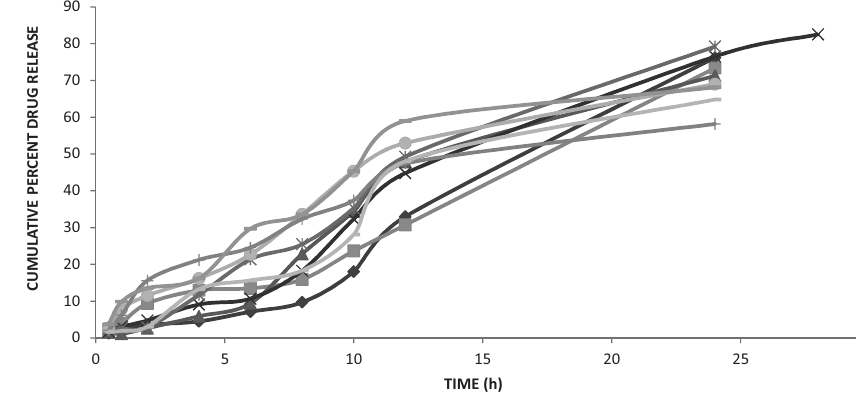
FIGURE 3 - In vitro drug release profiles of selegiline hydrochloride loaded chitosan